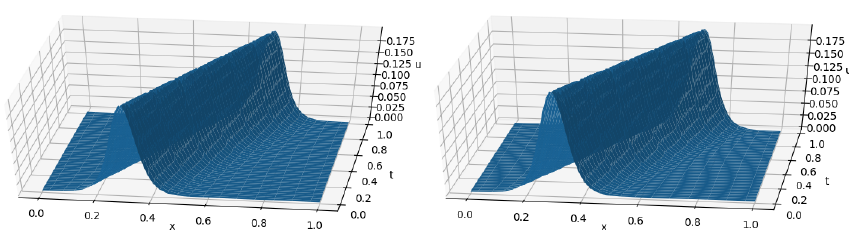
Figure 3. Example of how the adaptive grid changes with the changes in the waveform in case of the KdV equation: calculated solution (left) and exact solution